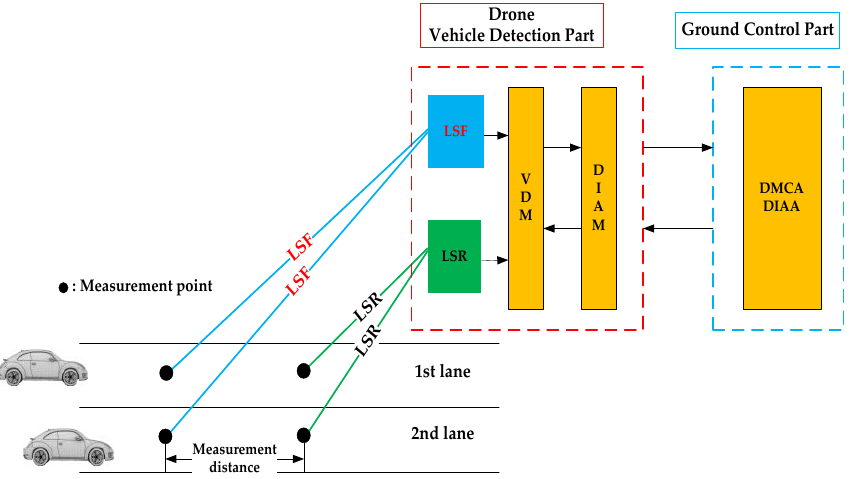
Figure 2. Vehicle information acquisition system: LSF—LiDAR sensor front; LSR—LiDAR sensor rear; VDM—Vehicle detection module; DIAM—Detection information acquisition module; DMCA—Detection module control analysis; DIAA—Detection information acquisition analysis.